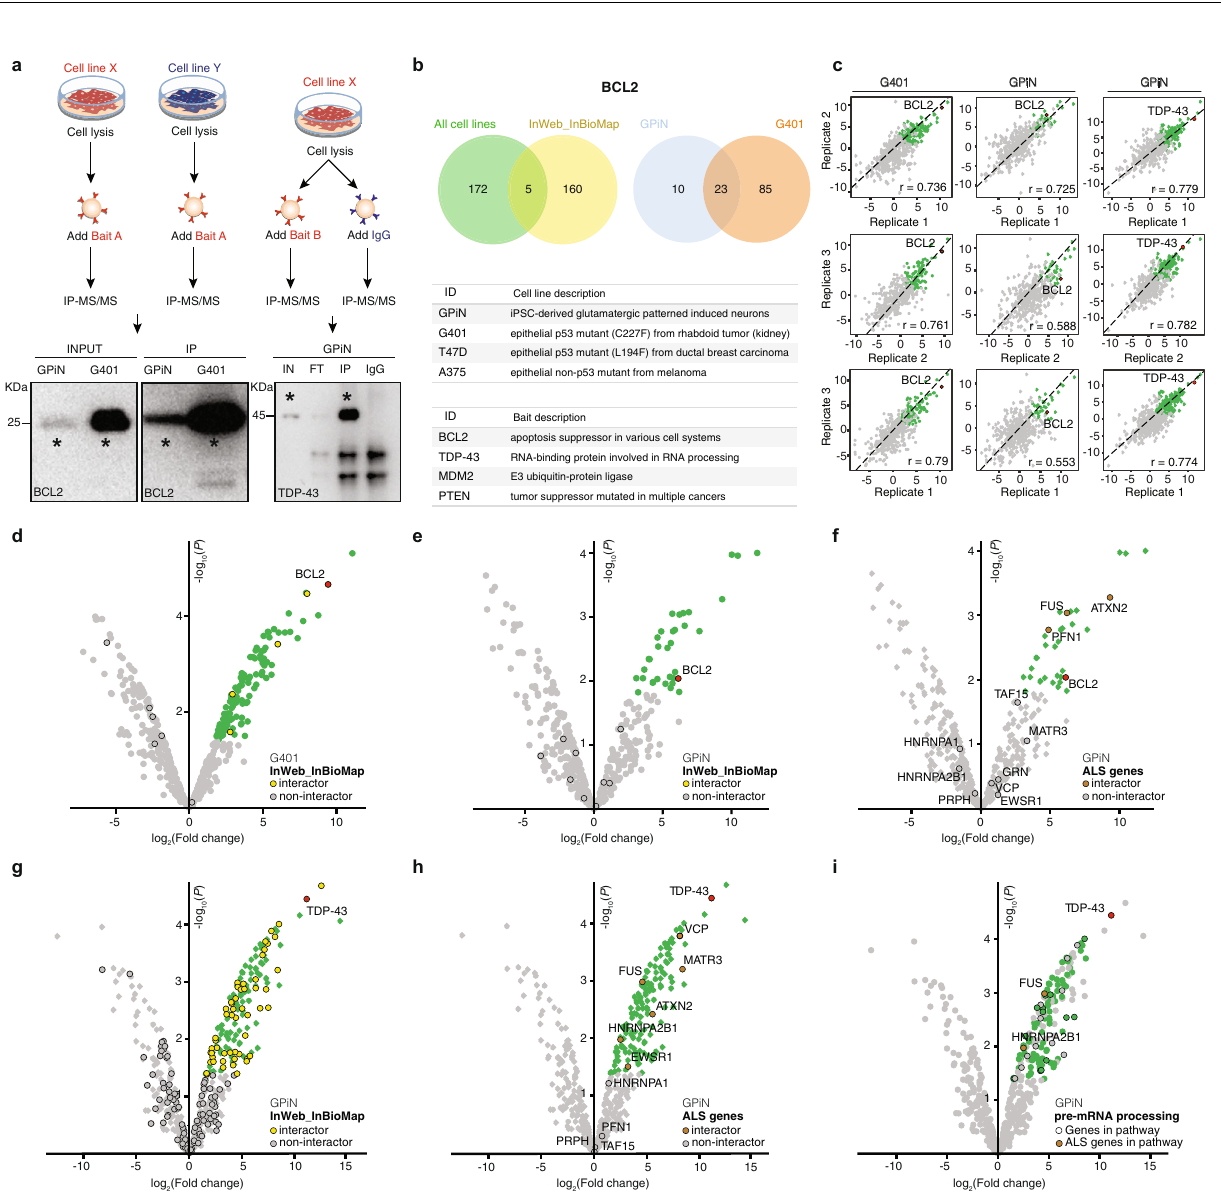
Fig. 2 IP-MS/MS analysis through Genoppi. a Experimental design and representative western blots of immunoprecipitations prepared for MS/MS analysis. The schematic to the left shows how Bait A (BCL2 as an example) was pulled down in two distinct cell lines (GPiN and G401) and detected in western blots carried out on cell lysate input and IP material from both cell lines. The schematic to the right exempli fi es the immunoprecipitation of Bait B (TDP-43 as an example) and the parallel addition of nonspeci fi c IgG control to GPiN lysates; a TDP-43 western blot was then performed on the cell lysate input, IP fl ow-through, IP, and IgG control. Each blot is representative of three IP replicates. Asterisks (*) indicate the band corresponding to each bait (BCL2 or TDP-43). b Top: Venn diagrams representing the overlap between BCL2 interactors identi fi ed in all cell lines and known InWeb_InBioMap interactors, and the overlap of interactors identi fi ed in neurons (GPiN) and a cancer cell line (G401). Bottom: complete list of cell lines and baits used for the experiments. c Scatter plots showing the reproducibility of three IP replicates in terms of log 2 FC correlation for three sets of experiments: BCL2 versus IgG control in G401 cells or GPiNs, and TDP-43 versus IgG control in GPiNs. Pearson ’ s correlation ( r ) is reported in each plot. d BCL2 versus IgG control IP results in G401 cells. The volcano plot is overlaid with known BCL2 interactors in InWeb_InBioMap (overlap enrichment P = 0.15). e , f BCL2 versus IgG control IP results in GPiNs. The volcano plot is overlaid with known BCL2 interactors in InWeb_InBioMap ( e ; overlap enrichment P = 1.0) or proteins encoded by ALS genes ( f ; overlap enrichment P = 0.041). g , h TDP-43 versus IgG control IP results in GPiNs. The volcano plot is overlaid with known TDP- 43 interactors in InWeb_InBioMap ( g ; overlap enrichment P = 0.085) or proteins encoded by ALS genes ( h ; overlap enrichment P = 0.046). In plots ( c – h ), the bait (BCL2 or TDP-43), interactors (log 2 FC > 0 and FDR ≤ 0.1), and non-interactors are shown in red, green, and gray, respectively; overlaid proteins are marked by black border circles, and their overlap enrichment P values were calculated using one-tailed hypergeometric tests. i TDP-43 versus IgG control IP results in GPiNs shown as volcano plot, with the bait (TDP-43) shown in red, interactors (log 2 FC > 0 and FDR ≤ 0.1) that are GPiN-speci fi c (i.e., not interactors in G401) in green, and other detected proteins in gray. Black border circles indicate interactors in the MSigDB Reactome “ processing of capped intron-containing pre-mRNA ” pathway; two GPiN-speci fi c interactors in the pathway, FUS and HNRNPA2B1, have been linked to ALS and are highlighted in brown. IN input, FT fl ow-through, IP immunoprecipitation, IgG Immunoglobulin G isotype control. Source data are provided as a Source Data fi